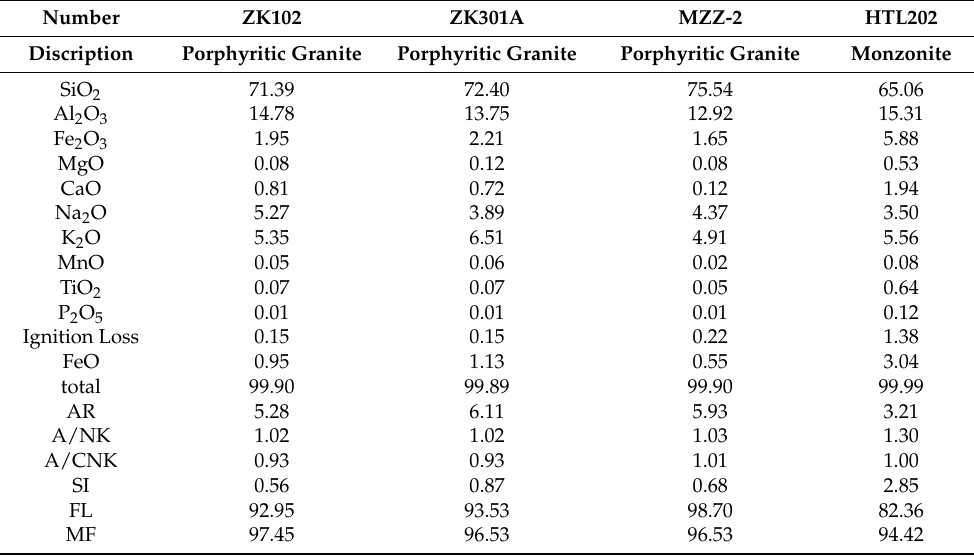
Table 4. Main element (wt %) analysis